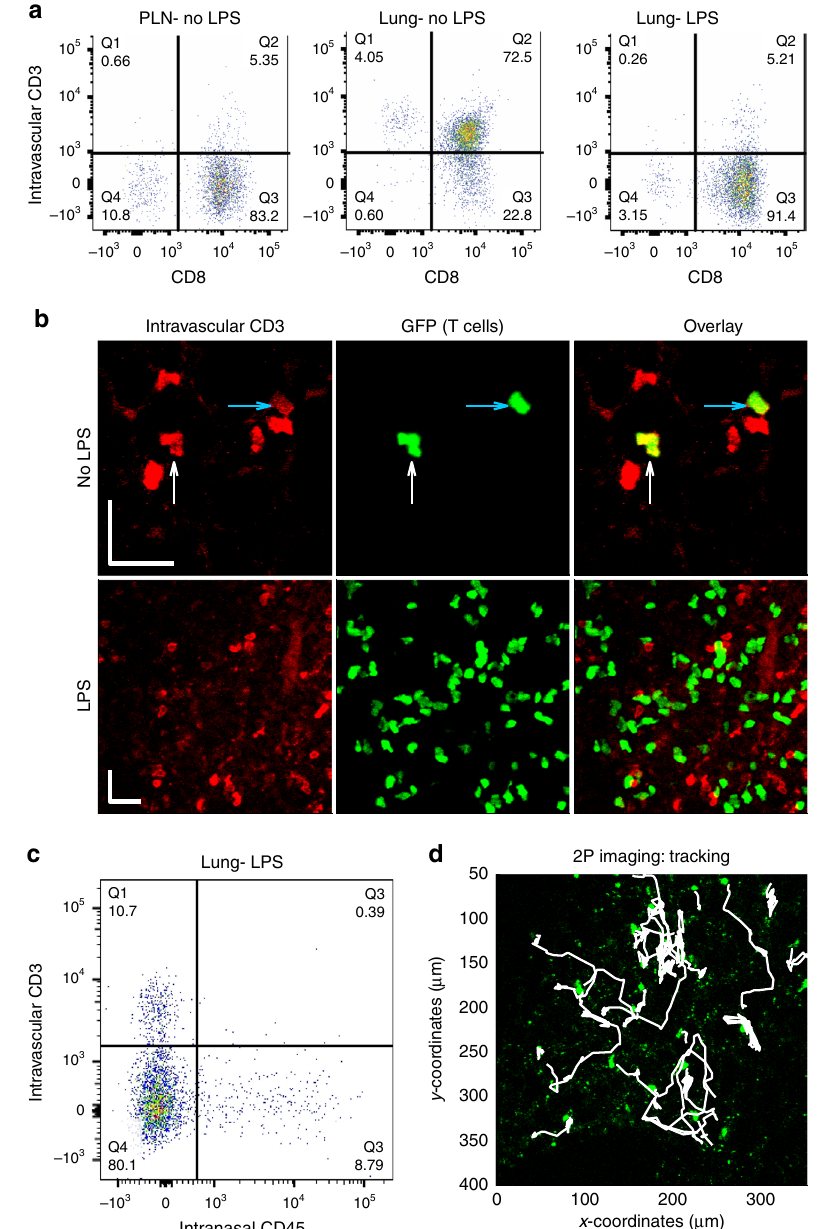
Fig. 1 Effector T cells localize to the interstitium of the lung upon in fl ammation. GFP + effector T cells were adoptively transferred into control and LPS- treated mice and analyzed two to fi ve days later. a , b Anti-CD3 antibody was injected i.v., followed 5 min later by harvest of peripheral lymph nodes (PLN) and lungs. a Single-cell suspensions from the harvested organs were stained with an anti-CD8 antibody and analyzed with fl ow cytometry. We gated for GFP + (adoptively transferred) T cells and show the percentage of extravascular (CD3 − ) and CD8 + T cells. b Lungs were fi xed with 4% paraformaldehyde and analyzed with confocal microscopy, enabling co-visualization of GFP + T cells ( green ) and the CD3 surface stain ( red ). Arrows highlight double-positive cells. Scale bars : 20 µ m. c Anesthetized mice were injected i.n. with anti-CD45 antibody. After a few minutes, anti-CD3 antibody was injected i.v.,